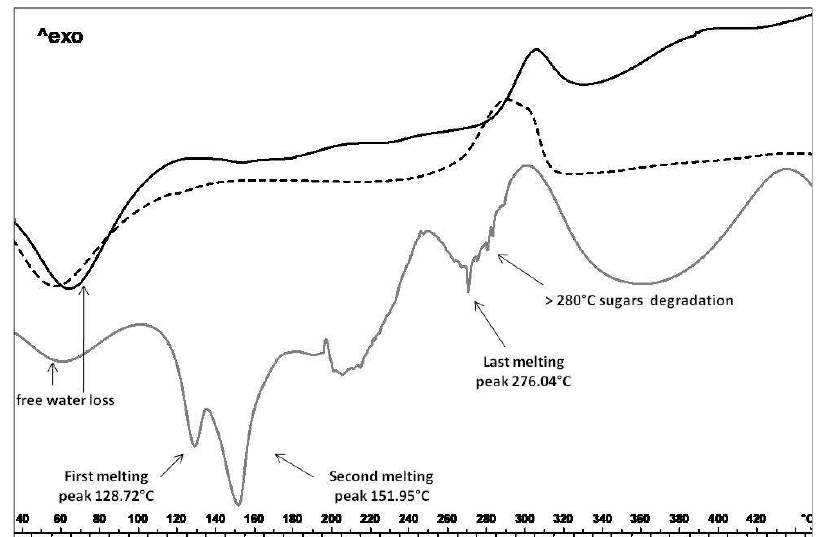
Figure 3. Differential scanning calorimetry analysis. MTE raw extract thermal profile (grey line); MTE_mp (black line) and blank_mp (dotted line).